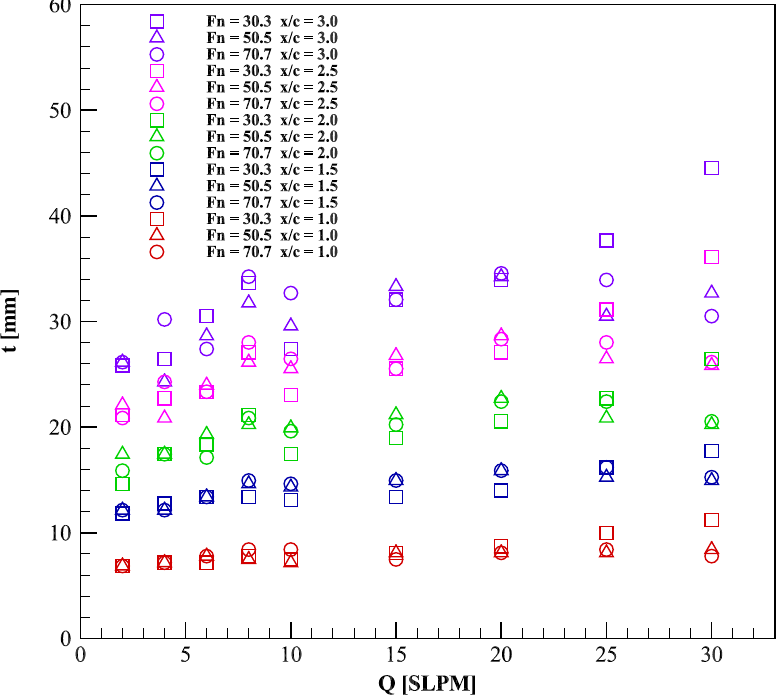
Figure 16. The jet thickness at various air injection rates, Q , and free-stream velocity, V ∞ .